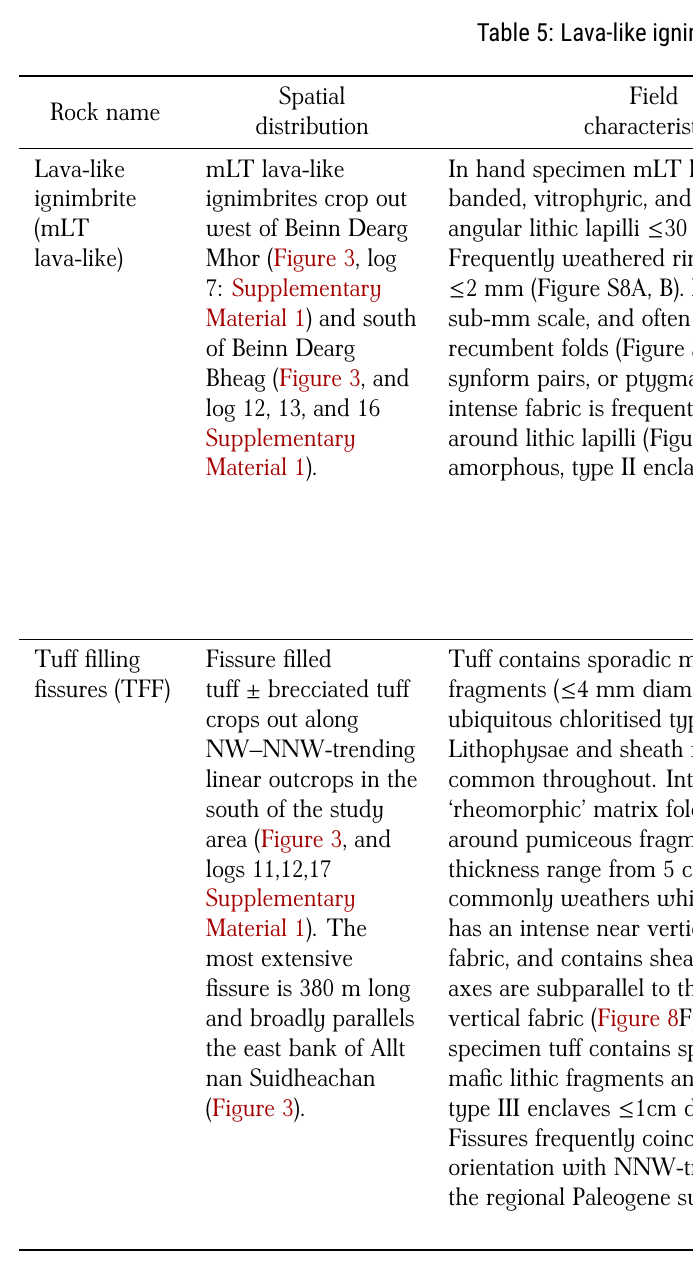
Table 5: Lava-like ignimbrite (mLT lava-like), and Tuff filling fissures (TFF) of the